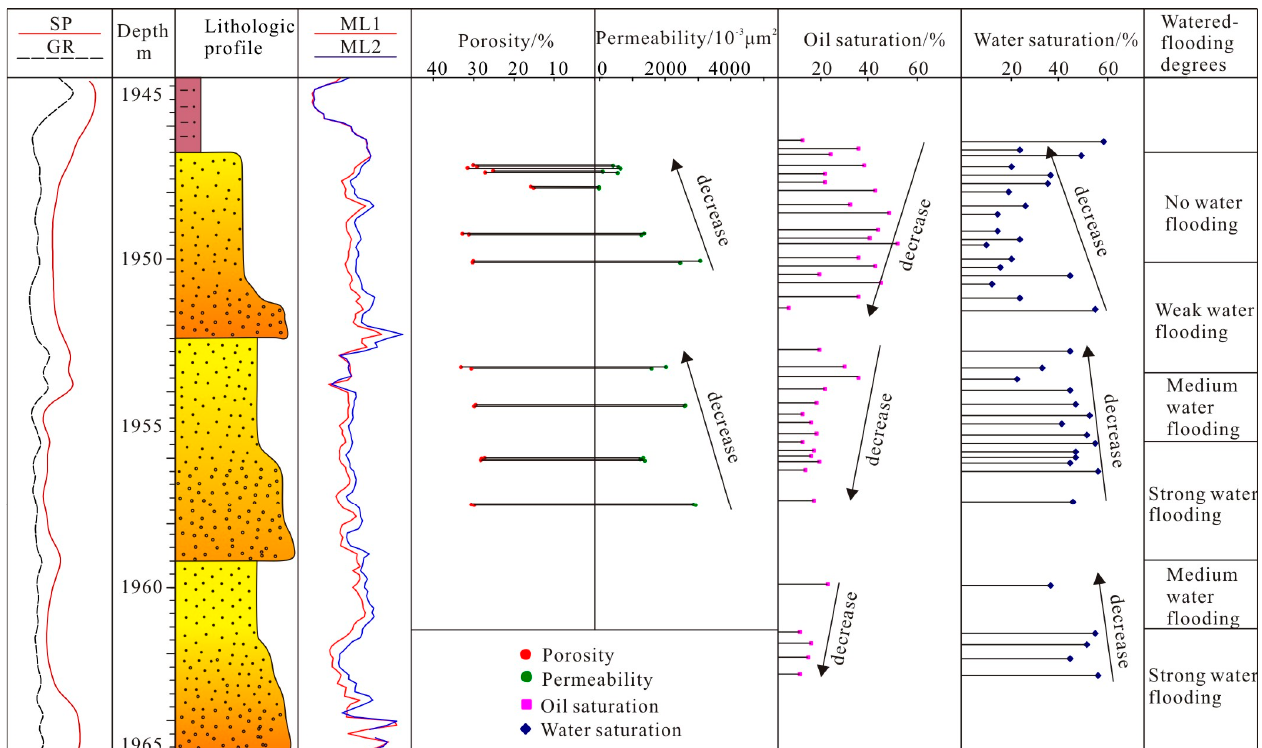
Figure 6. Influence of sedimentary rhythm on water-flooding degrees in the Zhenwu area, Gaoyou Sag.